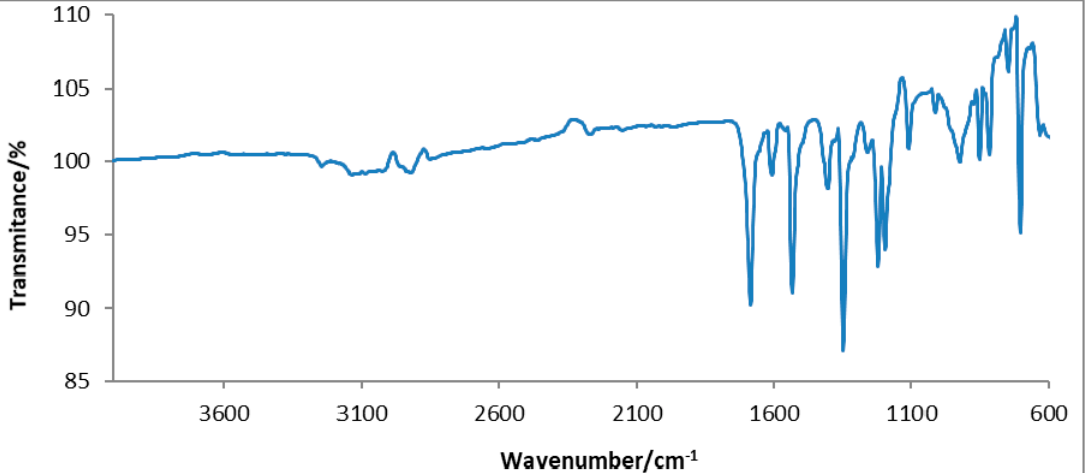
Figure 2. FTIR spectrum of copper(II) complex. 3.3. Thermogravimetric Studies in Air One of the simplest ways to determine if an obtained product is a coordination compound is to compare the thermal decomposition of the free ligand with the thermolysis of the complex. Both the organic ligand and the copper(II) coordination compound are stable at room temperature. Their thermal decompositions have been studied in air using TG-DTG (Figures 3 and 4). Thermolysis of the ligand starts at 160 °C. In the range of 160 to 320 °C, there is a destruction of uncoordinated molecules. It is accompanied by large and small peaks on the DTG curve at 220 and 270 °C, respectively. Further temperature elevation indicates the combustion of organic residue. After coordination, thermal stability decreases to 50 °C. At this temperature, both water molecules are released. On the TG curve is observed a loss in mass: found. 5.00%; calc. 4.46% (DTG peak at 80 °C). Above 110 °C, decomposition of the S-donor ligand is started (mass loss: found. 54.5%; calc. 54.33%) with large peaks on the DTG curve at 210 °C. Only the fragments related to the inner coordination sphere do not take part in decomposition. In the temperature range of 310 to 640 °C, there is total destruction of the coordination compound. The DTG curve shows the presence of one peak at 580 °C. The process stops at 645 °C, with pure CuO as a final solid product of pyrolysis. Theoretical results are in very good agreement with the experimental ones (CuO found 9.5%, calculated 9.85%). The thermolysis of the complex is illustrated in Table 1.